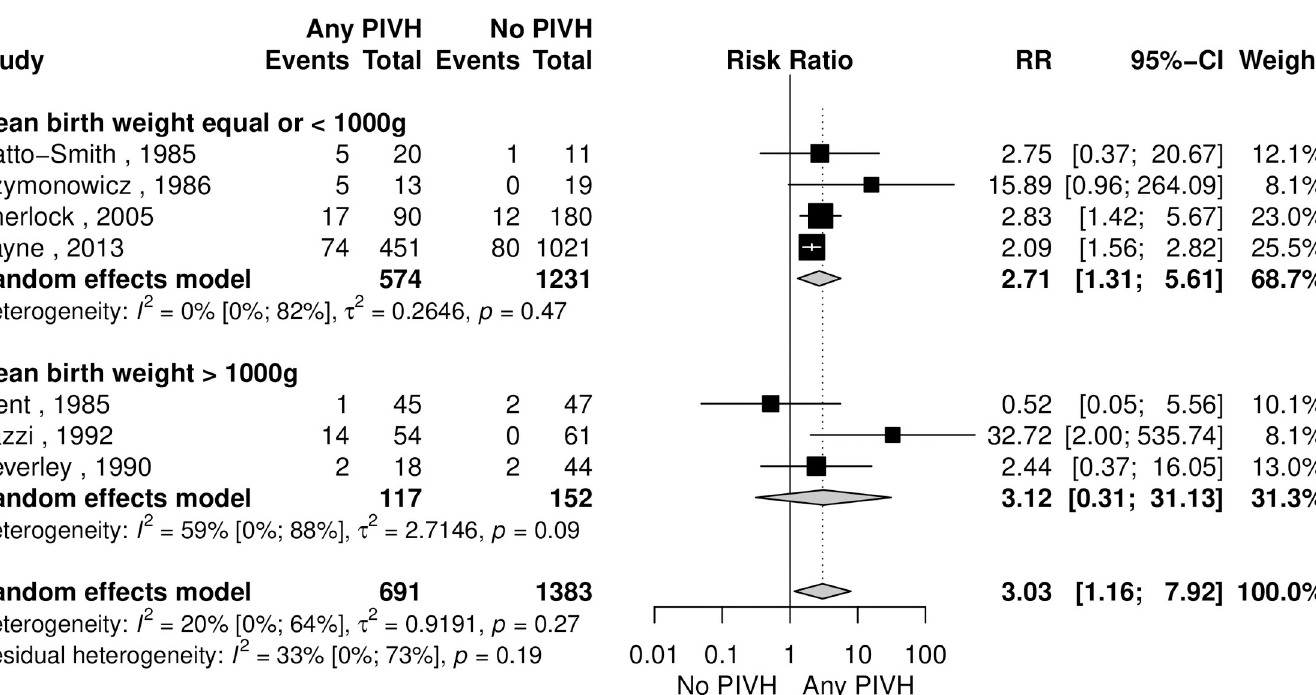
Fig 5. Subgroup analysis of cerebral palsy comparing children with any Peri-Intraventricular Haemorrhage (PIVH) and those without PIVH, by birth weight (BW).